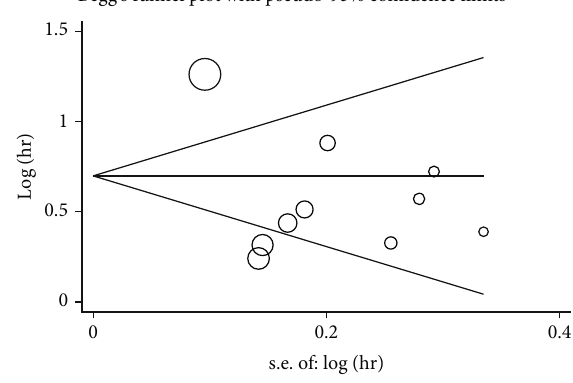
Figure 4: Begg ’ s funnel plot for the publication bias test.